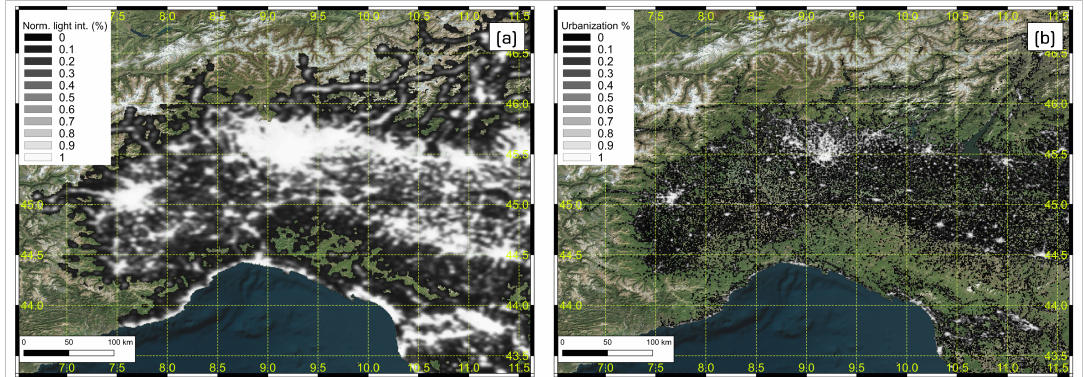
Figure 4. Outputs of data homogenization: ( a ) normalized DMSP night-time light intensity map (30 arc seconds, 2011) ( b ) normalized and co-registered (on the same grid of DMSP) urban density as obtained from the GUF map by DLR (12 m,